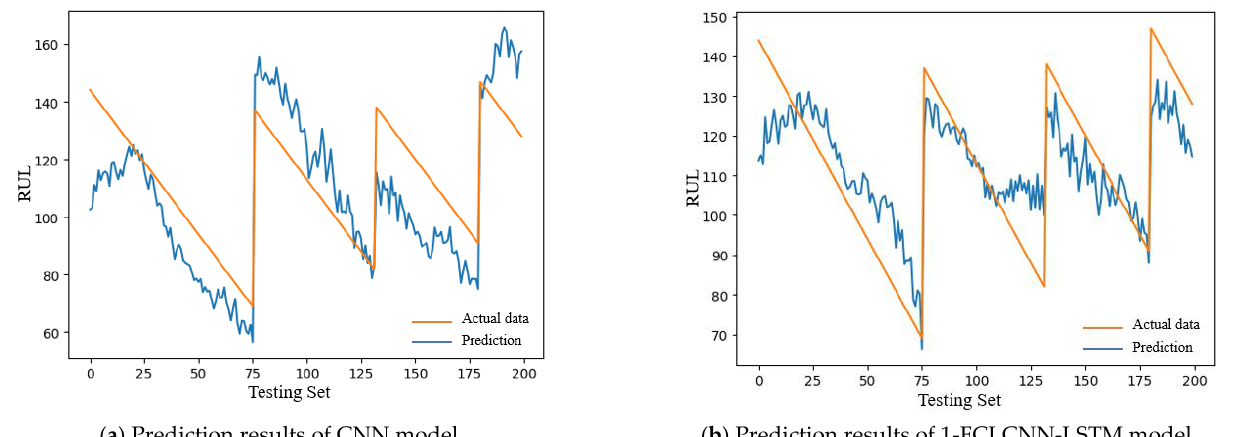
Figure 14. RUL prediction results of FD001 with different models.